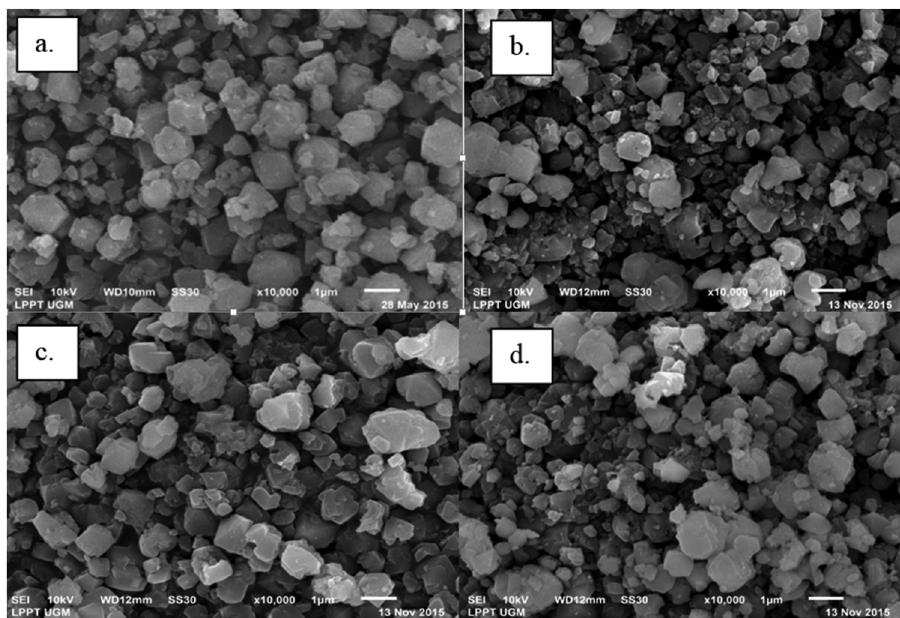
Figure 5: Morphology of ( a ) USY; catalyst after reduction process that produces by ( b ) co impregnation methods ( Ar ) ; sequential impreg - nation methods where ( c ) cobalt was impregnated fi rstly followed by Molybdenum precursor ( Br ) , and vice versa ( d ) molybdenum was impregnated fi rst followed by cobalt precursor.